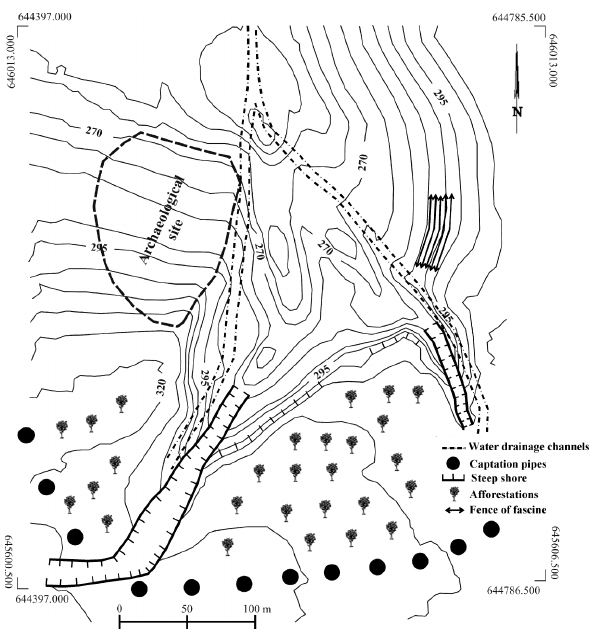
Fig. 27. Proposal for the development of the Cucuteni-Baiceni gully